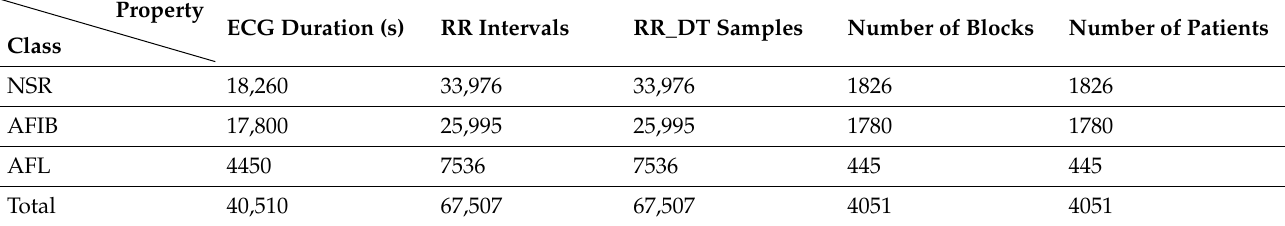
Table 1. Data properties for the three signal classes. The ‘ECG Duration (s)’ column provides the time duration of all ECG signal blocks for each individual class. After that, the two columns to the right provide the number of RR intervals and the number of RR_DT samples, respectively. The last two columns on the right provide the number of blocks and number of patients for each signal